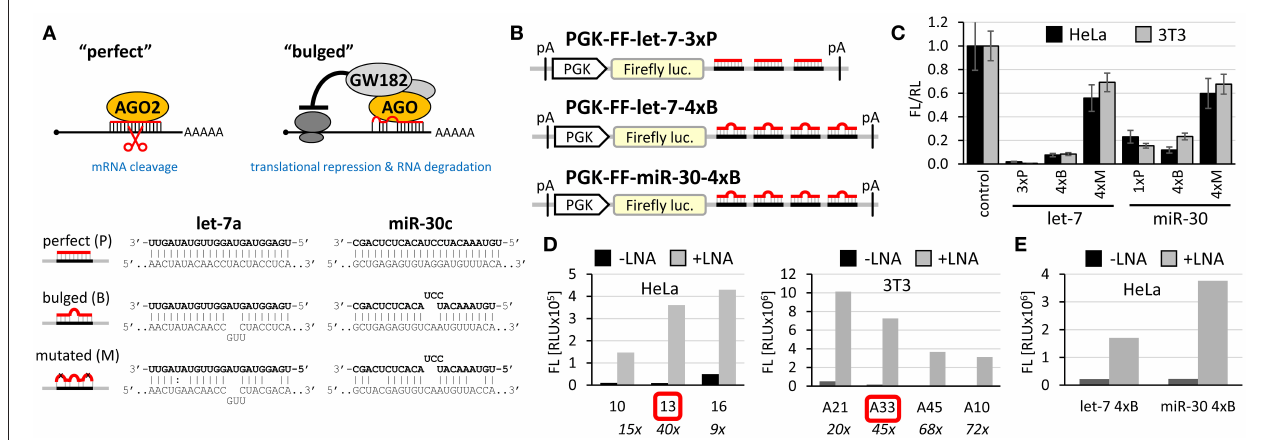
FIGURE 1 | Firefly luciferase reporter systems for HTS. (A) “Perfect” and “bulged” binding sites for let-7a and miR-30c miRNAs. A “perfect” site yields perfect base-pairing. If miRNA is bound to AGO2, this type of binding will yield endonucleolytic cleavage in the middle of the base-paired sequence. A “bulged” site is a typical natural miRNA binding site. In this case, silencing of a cognate mRNA requires AGO and associated proteins. Mutated sites carry mutations that should prevent miRNA-mediated repression. (B) Schematic structure of let-7 and miR-30 firefly luciferase reporters used for HTS. pA, polyadenylation signal. (C) Reporter activities upon transient co-transfection with plasmids expressing firefly luciferase without specific miRNA binding sites. The experiment was performed three times, data were normalized to co-transfected non-targeted Renilla luciferase, and the control (firefly luciferase reporter without any miRNA binding sites) was set to one. Except for the control and 1xP miR-30 reporters, which utilized the SV40 promoter and 3 ′ UTR, all other reporters were driven by the PGK promoter and had BGH 3 ′ UTR. Error bar = standard deviation (SD). (D) Firefly activity test of specific HeLa and 3T3 clones stably expressing PGK-FF-let-7-3xP reporter upon let-7 repression with let-7 LNA inhibitors (50nM). Clones 13 and A33 were selected for HTS. (E) Firefly activity test of specific HeLa cells stably transfected with PGK-FF-let-7-4xB or PGK-FF-miR-30-4xB reporters upon miRNA repression with LNA inhibitors (50nM). Firefly luciferase activities are displayed as relative luciferase units (RLU) recorded by the